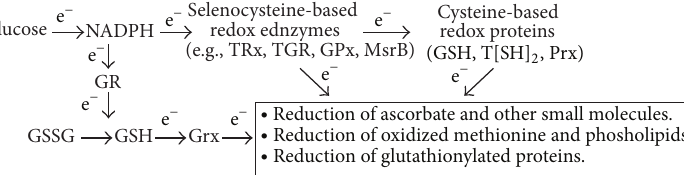
Figure 2: Selenoenzymes are central to providing antioxidant electrons to accomplish reduction of molecules in a number of biochemical processes. NADPH = nicotinamide adenine dinucleotide phosphate; GR = glutathione reductase; T(SH) 2 = reduced thioredoxin; GSH = reduced glutathione; TRx = thioredoxin reductase; GSSG = oxidized glutathione; TGR = thioredoxin-glutathione reductase; GPx = glutathione peroxidase; MsrB = methionine sulfoxide reductase; Prx = peroxiredoxin; Grx = glutaredoxin; e − = electron. Levels of plasma GSH, erythrocyte NADH, and NADPH are notably reduced ( 𝑃 < 0.001 ) in children with autism [16,